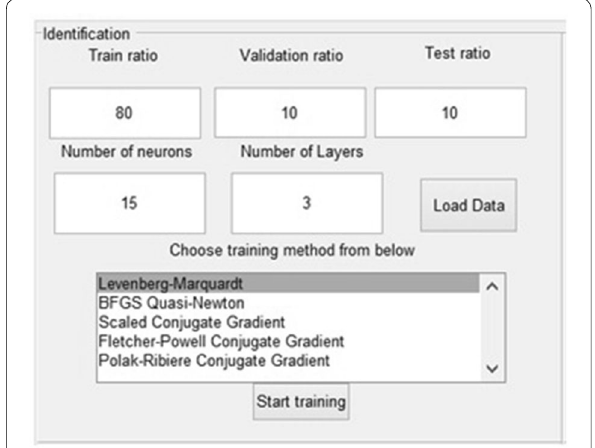
tification panel (upper left), the modeling panel (upper right) and the plotting panel (bottom panel) which is used by both identification and modeling